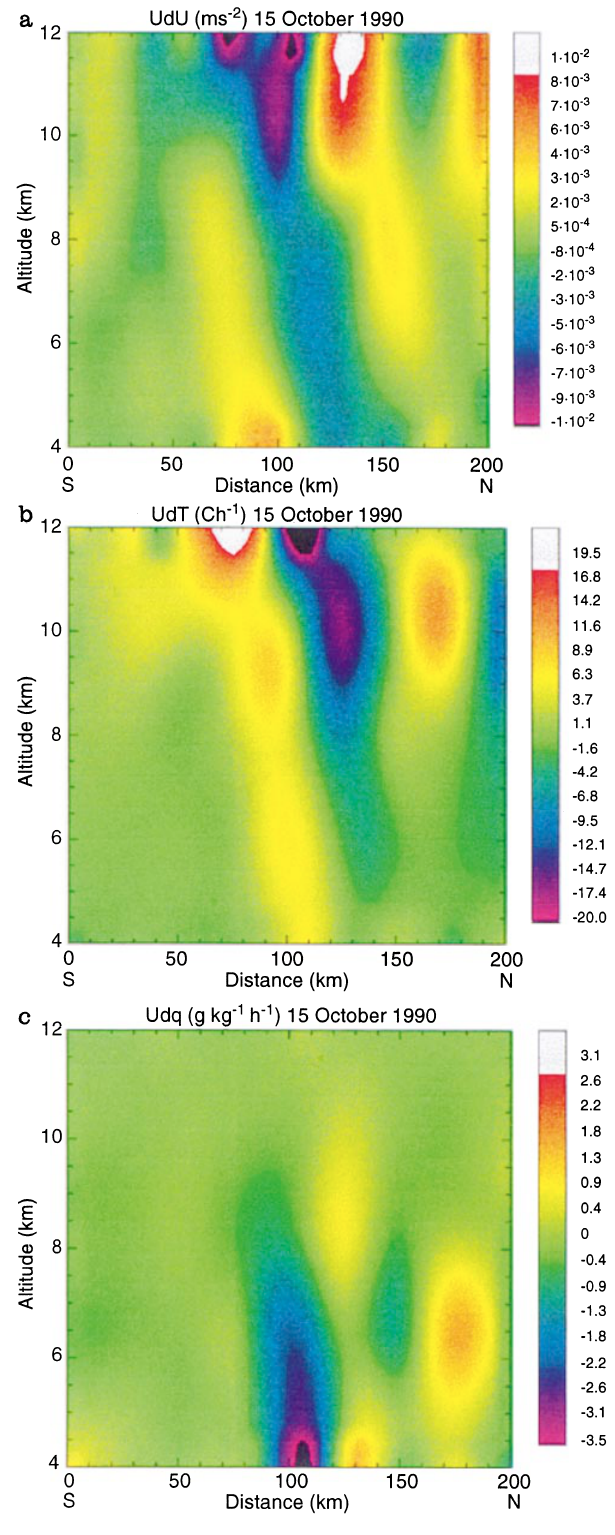
Fig. 12. a horizontal advection of wind (in m s (cid:255) 2 ); b of potential temperature (in (cid:14) C h (cid:255) 1 ) and c of specific humidity (in g kg (cid:255) 1 h (cid:255) 1 )